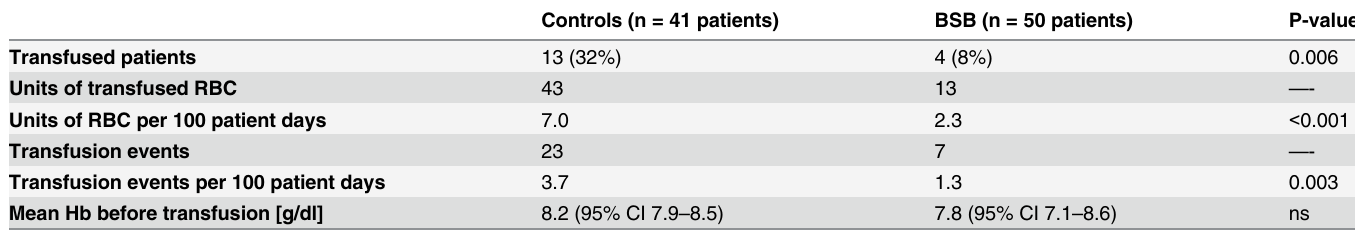
Table 4. Blood transfusions.